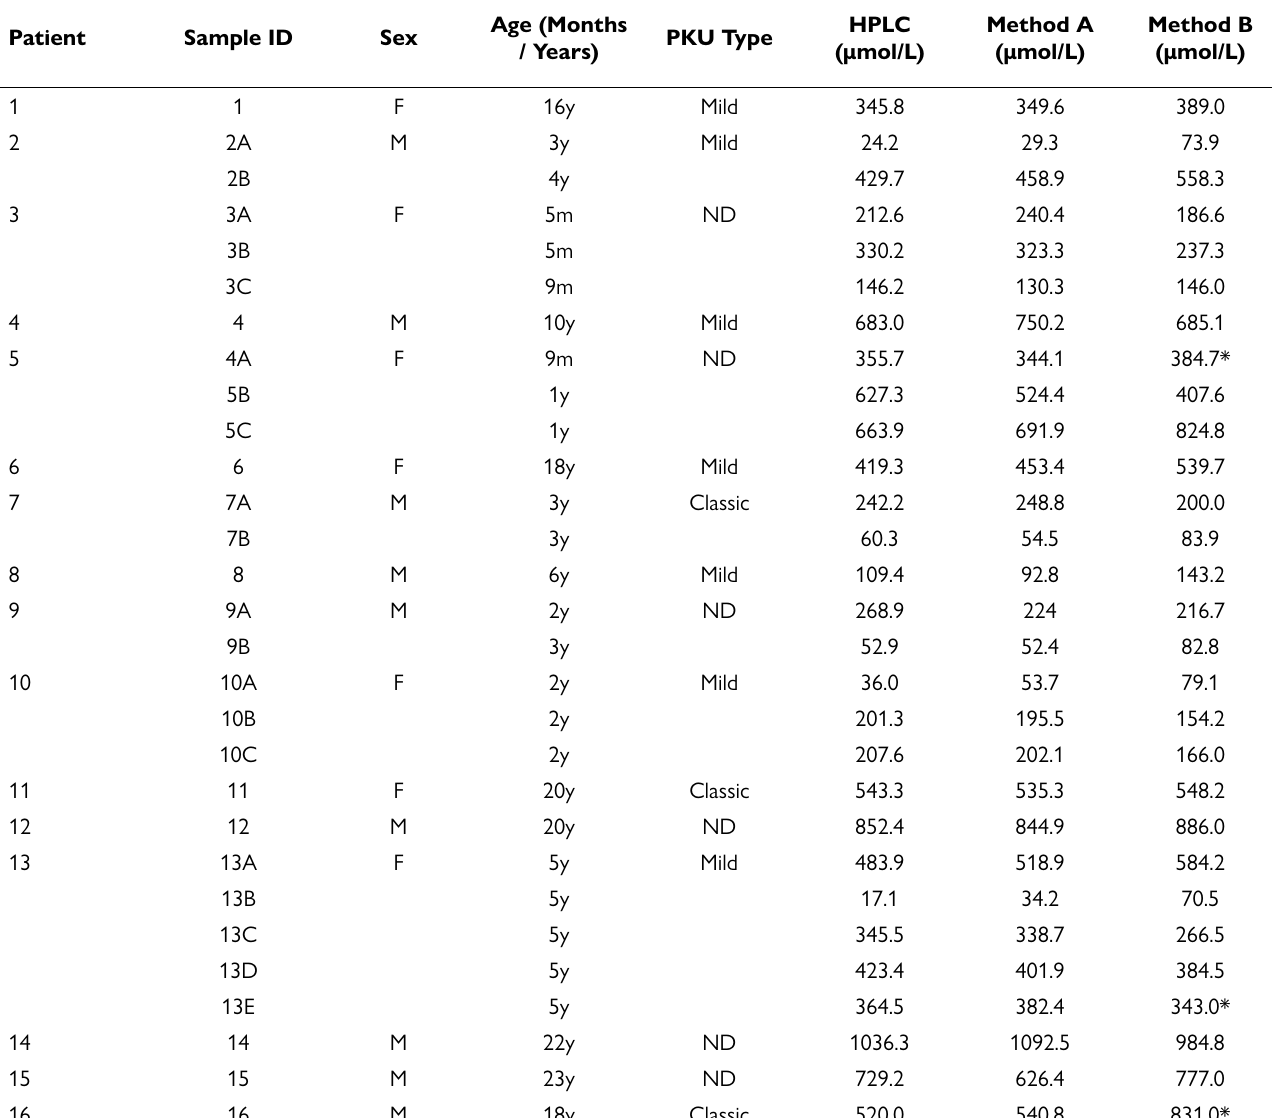
Table 1. Sample description and assay